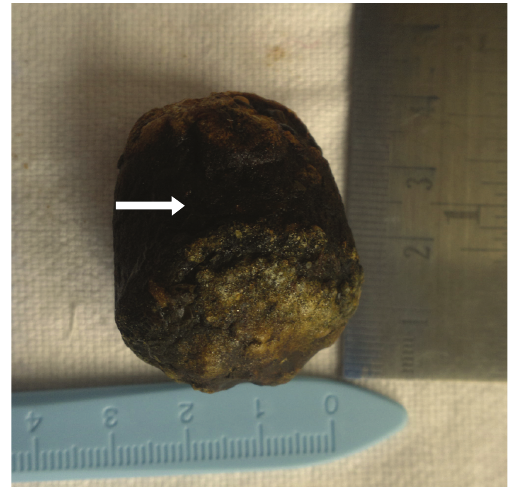
Figure 5: The hardshelled gallstone after